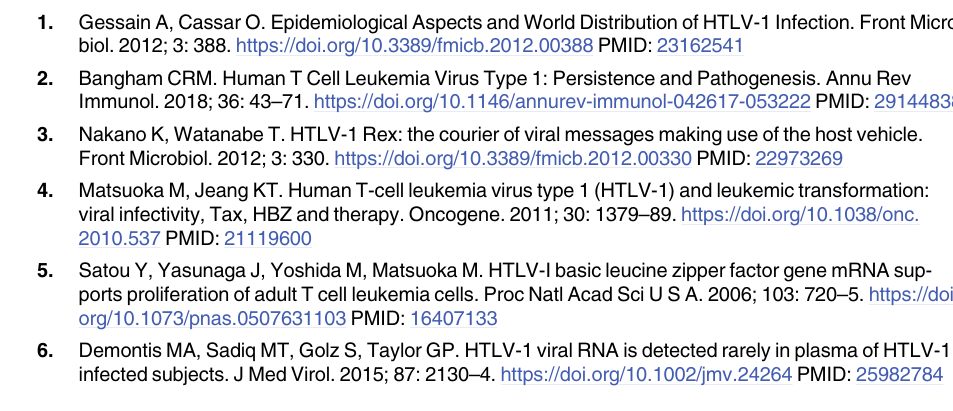
S1 Data. Excel workbook containing the numerical data used to generate the figures. Each named sheet within the workbook contains the numerical values of the corresponding figure